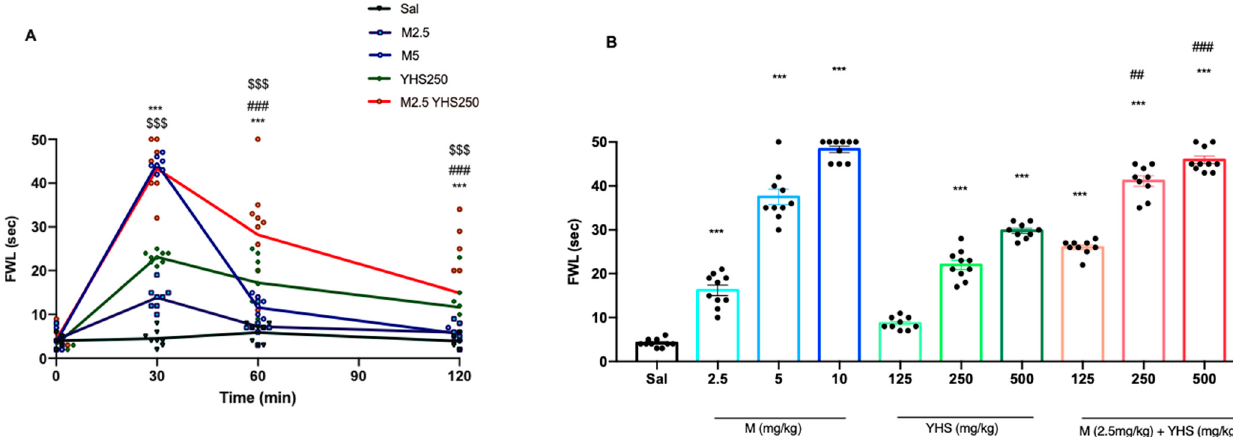
Figure 1. YHS increases morphine antinociception. A: Foot withdrawal latency (FWL) of mice injected with saline, morphine (2.5 mg/kg), YHS (250 mg/kg), or the combination of morphine and YHS (2.5 mg and 250 mg/kg, respectively) at 30, 60, and 120 min after i.p. administration (n = 10). The black dots correlate to the number of animals used in each experiment. Two-way ANOVA revealed significant drug effects F (3, 288) = 332.8 p < 0.0001, time effect F (4, 288) = 217.5 p < 0.0001, and drug x interaction time F (12, 288) = 55.29 p < 0.0001, followed by Tukey’s multiple comparison test *** p < 0.001 compared with M2.5 mg/kg, $$$ p < 0.0001 compared with saline, ### p < 0.0001 compared with M5 mg/kg. B: FWL at 30 min after morphine (2.5 mg/kg, 5 mg/kg, 10 mg/kg), YHS (125 mg/kg, 250 mg/kg, 500 mg/kg),or morphine + YHS (n = 9–10) i.p. administration. One-way ANOVA revealed significant drug effects F = 247.2, p < 0.0001, followed by Tukey’s multiple comparison test *** p < 0.001 compared with saline, ## p < 0.01, ### p < 0.001 compared with M2.5 mg/kg. YHS prevents morphine tolerance.